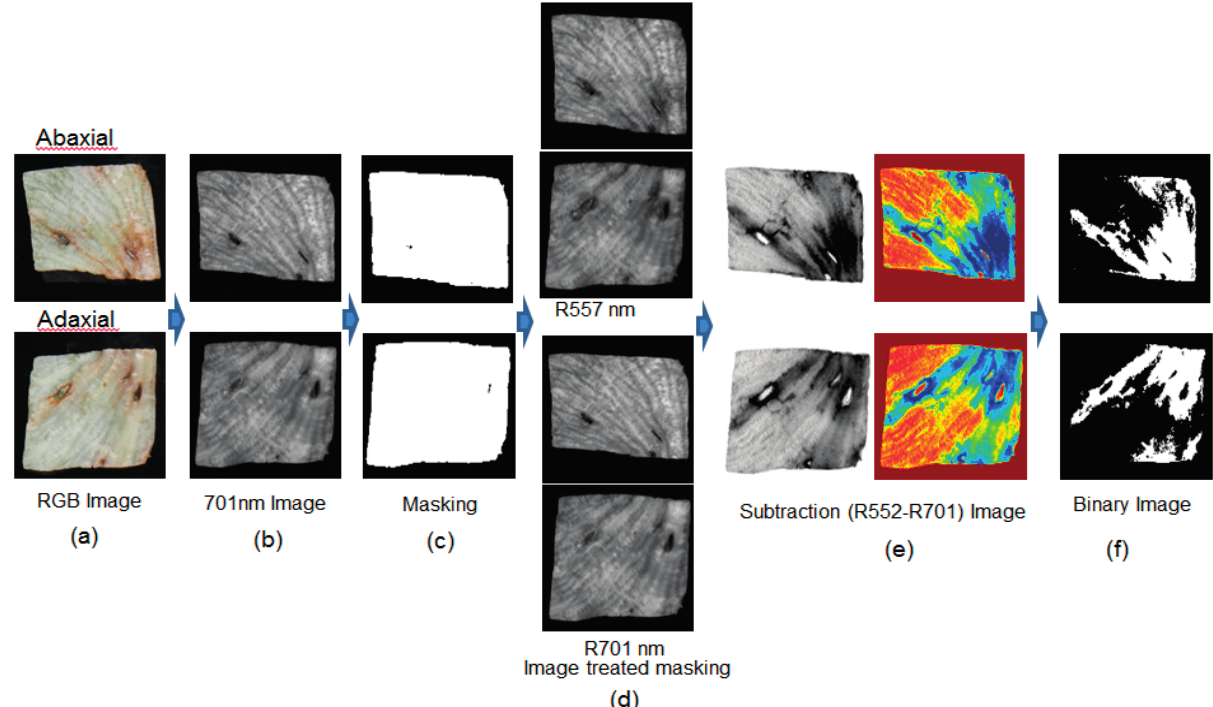
Figure 13. Illustration of image processing sequence for the subtraction imaging